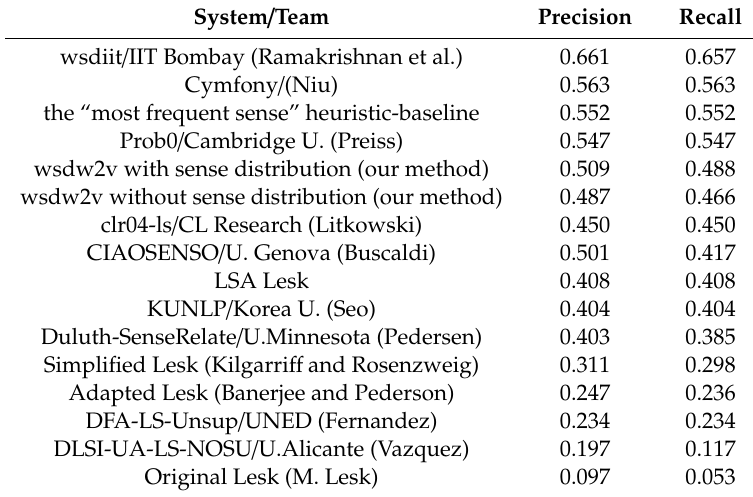
Table 6. Performance of unsupervised systems participating in the SENSEVAL-3 English lexical sample task compared with our method and